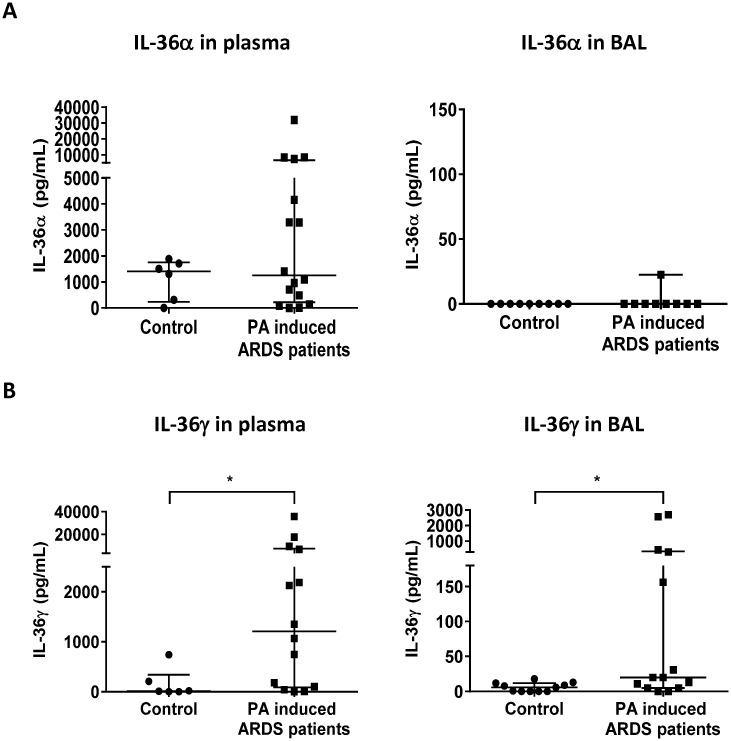
Elevated IL-36γ in patients with P. aeruginosa induced ARDS.Plasma and BAL samples were obtained from acute respiratory distress syndrome (ARDS) patients caused by P. aeruginosa from day 0 to day 7 after onset and healthy control. The levels of (A) IL-36α and (B) IL-36γ in plasma and BAL were measured by ELISA. Sample number: healthy control (plasma; n = 6 and BAL; n = 9), patients with P. aeruginosa induced ARDS (plasma; n = 16 and BAL; n = 10). All data were showed as median with interquartile range. * p<0.05 compared with healthy control.